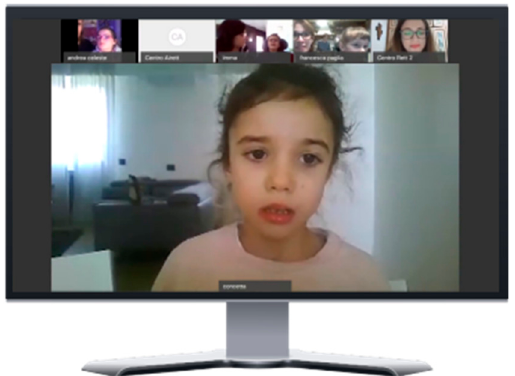
Figure 2. Most Video Conferencing Systems (VCS) show several users at a time on the screen.